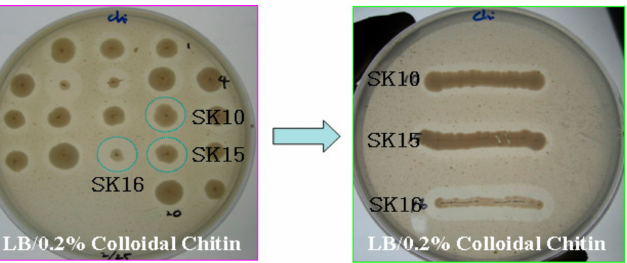
Figure 1. Growth and chitinolytic activities of the chitin-degrading microorganisms isolated from mudflats on LB containing 0.2% colloidal chitin (LBCC) agar plates. Each strain was streaked on LBCC agar plates and incubated at 30 ◦ C for three